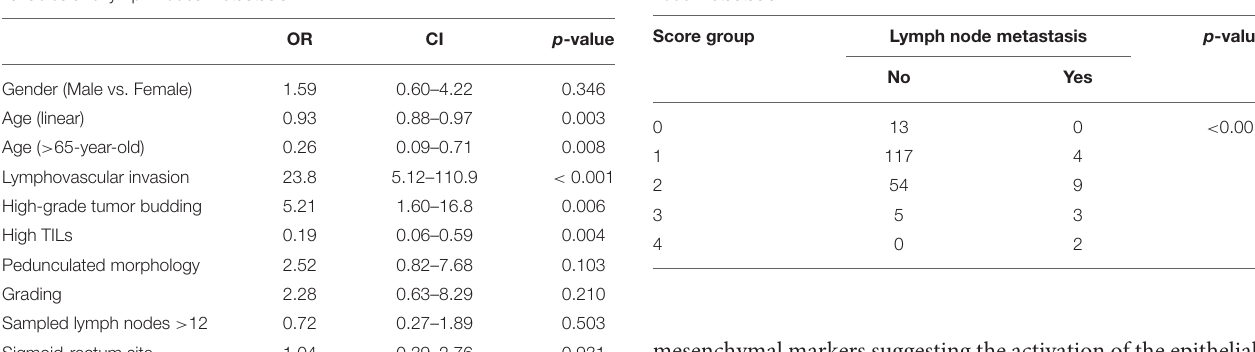
TABLE 4 | Correlation analysis between the score group and presence of lymph node